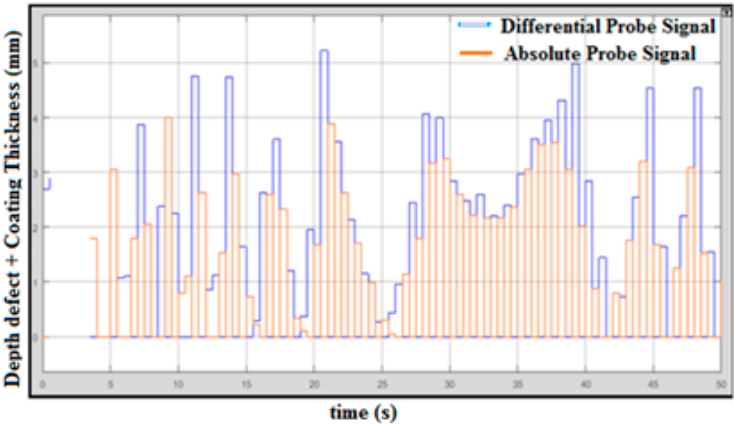
Figure 10. Integrated Probe Output without Coating Thickness.